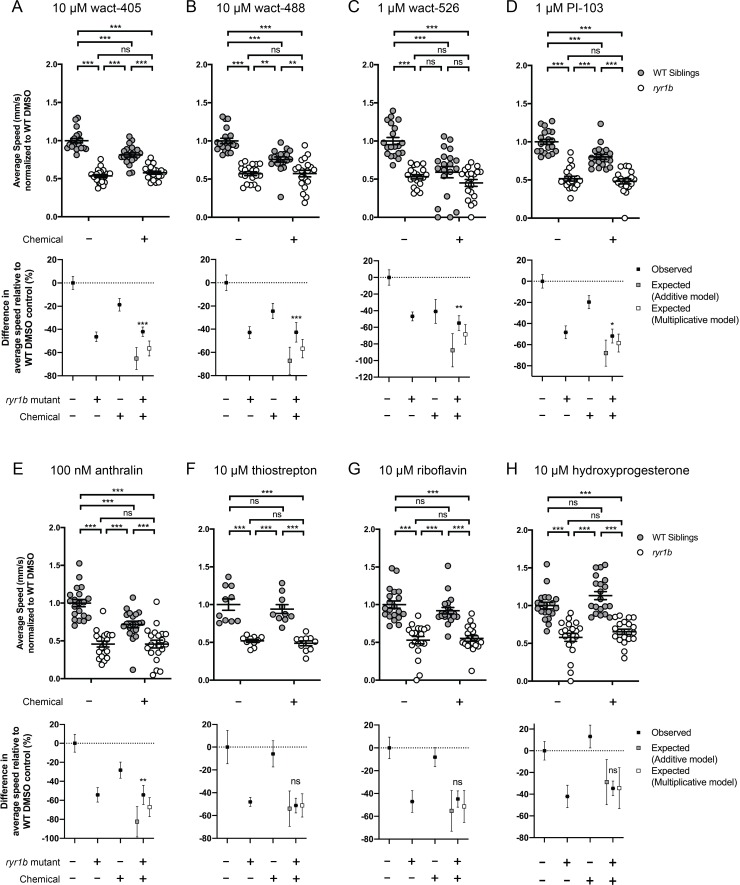
Chemical-genetic interactions were tested using zebrafish larval movement speed as a readout.Compared to the average speed of DMSO WT controls, treatment with (A) wact-405, (B) wact-488, (C) wact-526, (D) PI3K inhibitor PI-103, and (E) anthralin reduced the average speed of WT siblings while the expected decrease in movement speed in treated ryr1b was not observed. The difference in average speed of ryr1b+p38 inhibitor compared to WT controls (i.e. WT siblings+DMSO vehicle) is higher than expected given the effects of genotype and chemical alone, indicative of a positive chemical-genetic interaction. Chemical-genetic interactions were not observed for the remaining 18 hits from the C. elegans screen when tested in this assay (Figure 4—figure supplement 2–3F–W). Data are presented as mean ± SEM movement speed (mm/s) normalized to DMSO-treated WT siblings for n = 2 independent experiments for (A–E), (G), (H), (K), (L), and R), where sample size n = 19 or 20 for each treatment group in a set and n = 1 experiment and sample size n = 9 or 10 for the remainder. Statistical analysis by two-way ANOVA followed by Tukey’s multiple comparisons post-test. *p<0.05, **p<0.01, ***p<0.001.